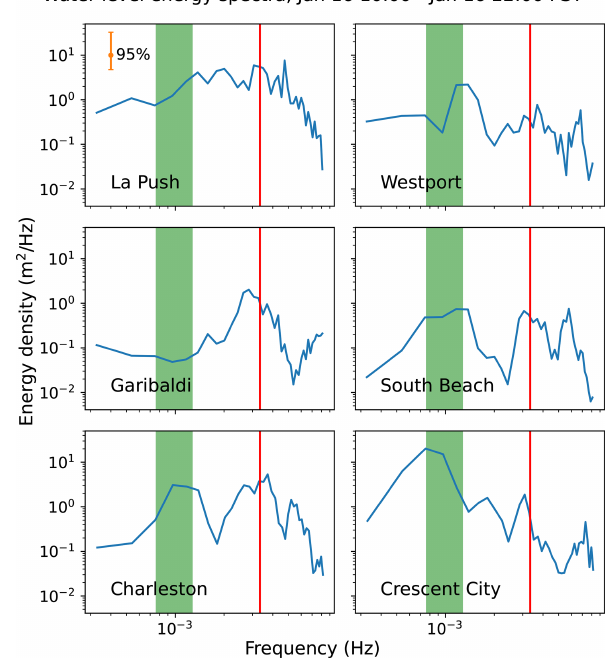
Figure 6. Energy density spectra of the water level at NOAA CO- OPS tide gages from 16 January 2016, 10:00, to 16 January 2016, 22:00. Vertical red lines are located at periods of 5min. Green boxes span the periods between 13 and 22min. Analysis is performed via fast Fourier transform with 18 degrees of freedom over record lengths between 708 and